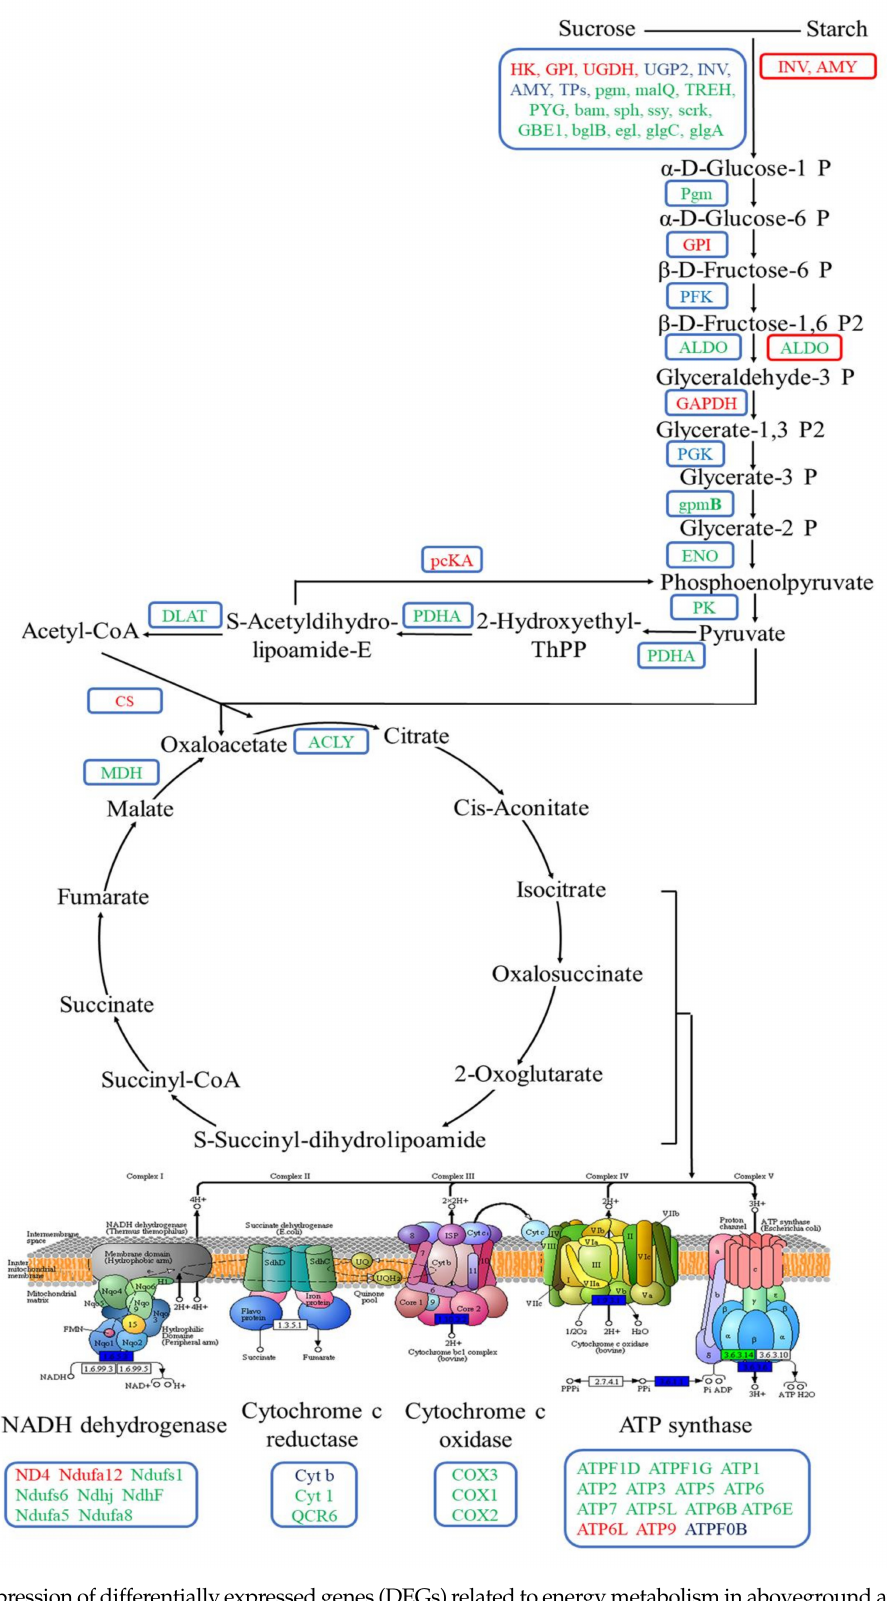
Figure 9. The expression of differentially expressed genes (DEGs) related to energy metabolism in aboveground and